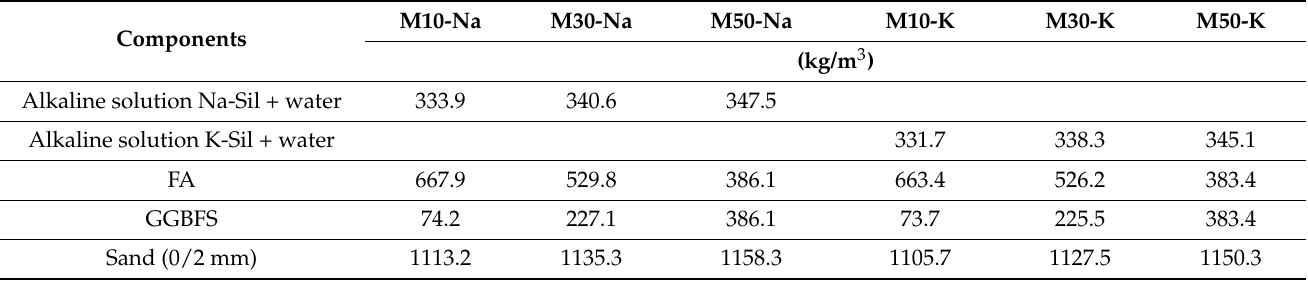
Table 5. Mix compositions of geopolymer mortars with sodium and potassium silicate